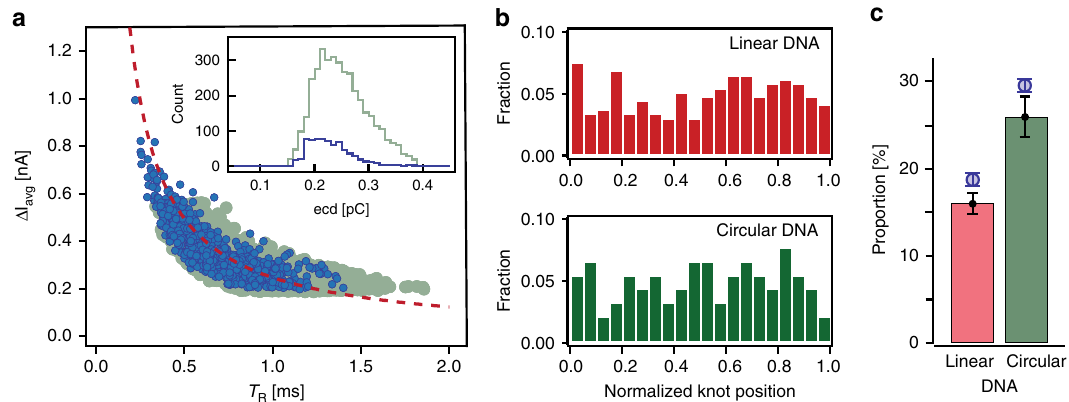
(cid:4) (cid:5) versus translocation time ( T R ) for unknotted (light green circles) and Fig. 2 Detection of equilibrium knots. a Scatter plot of average current blockade Δ I avg knotted events (darker blue circles). All the events follow the hyperbolic curve of constant event charge de fi cit (ecd), i.e., constant apparent length of the molecule. Inset: histogram of ecd for knotted events (lighter green) and unknotted events (darker blue) shows similar average values (0.25pC for unknotted and 0.23pC for knotted events) and distributions, indicating no effects of knots on the DNA translocation speed. b Histogram for normalized center position of knots on linear (red), as well as circular (green) DNA molecules shows that the knots are randomly located along the length of the molecule. c Proportion of lambda DNA molecules with knots, in linear and circular con fi gurations; experiment results presented with bars and simulation with circles (effective chain width w DNA = 2.4nm). Error bars show the statistical error, assuming Poisson statistics. Source Data are provided as a Source Data fi